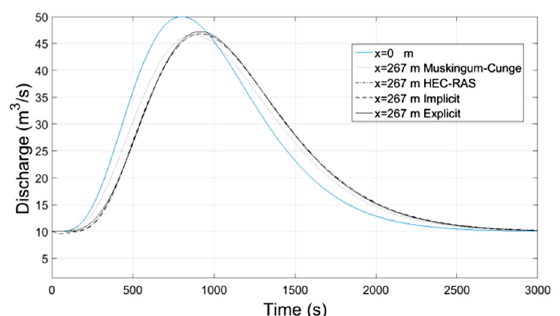
Figure 16. Discharge-Time at x = 267